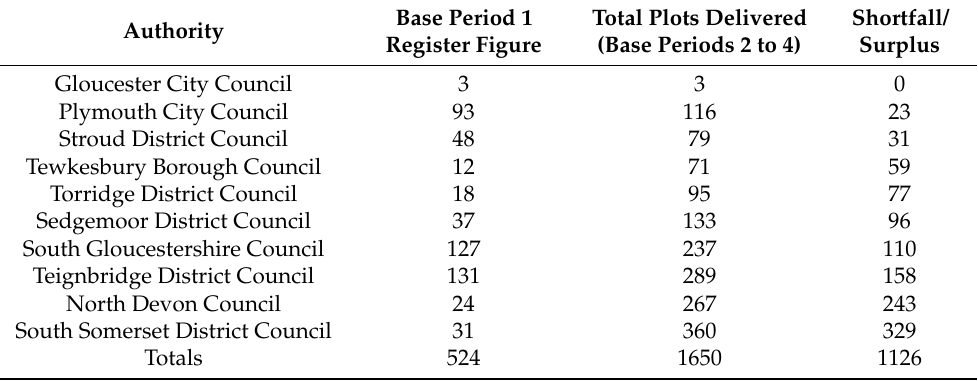
Table 15. Base period one demand data compared with permissions granted between base periods two to